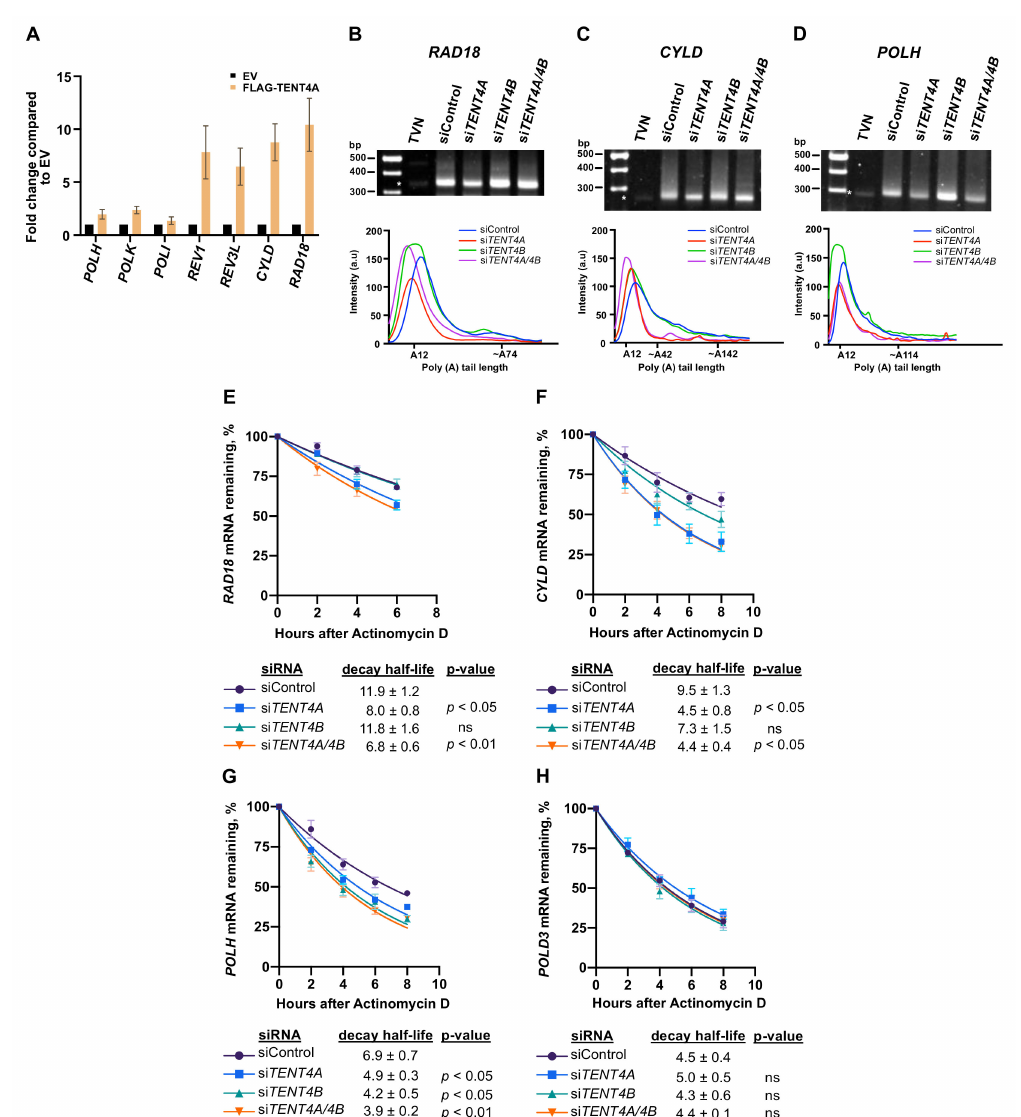
Figure 2. Effect of TENT4A on binding and stability of TLS-related mRNAs. ( A ) FLAG-tagged TENT4A expressed in HEK293T cells was immunoprecipitated with an anti-FLAG antibody and RNA bound to it was analyzed by qPCR. The results are shown as fold-change relative to empty vector. The error bars indicate SEM (two independent experiments). ( B – D ) Representative gel images of RAD18 , CYLD and POLH poly(A) tail are shown, each with the poly(A) tail densitometric trace underneath, using Image J. The position of TVN is indicated by an asterisk that predominantly recognizes A12, serving as an internal control. ( E – H ), TENT4A and/or TENT4B expression was knocked down in MCF-7 cells for 48 h, after which the cells were treated with 5 µ g/mL Actinomycin D for up to 8 h. The expression levels of RAD18 , CYLD , POLH and POLD3 genes were each determined by qPCR relative to the expression level at time 0. Half-life was calculated by using non-linear fit one-phase decay curve equation. The significance of the differences was calculated using Student’s t-test (one-tailed); Data are presented as mean ± SEM from three independent experiments. ns, non-significant; p >